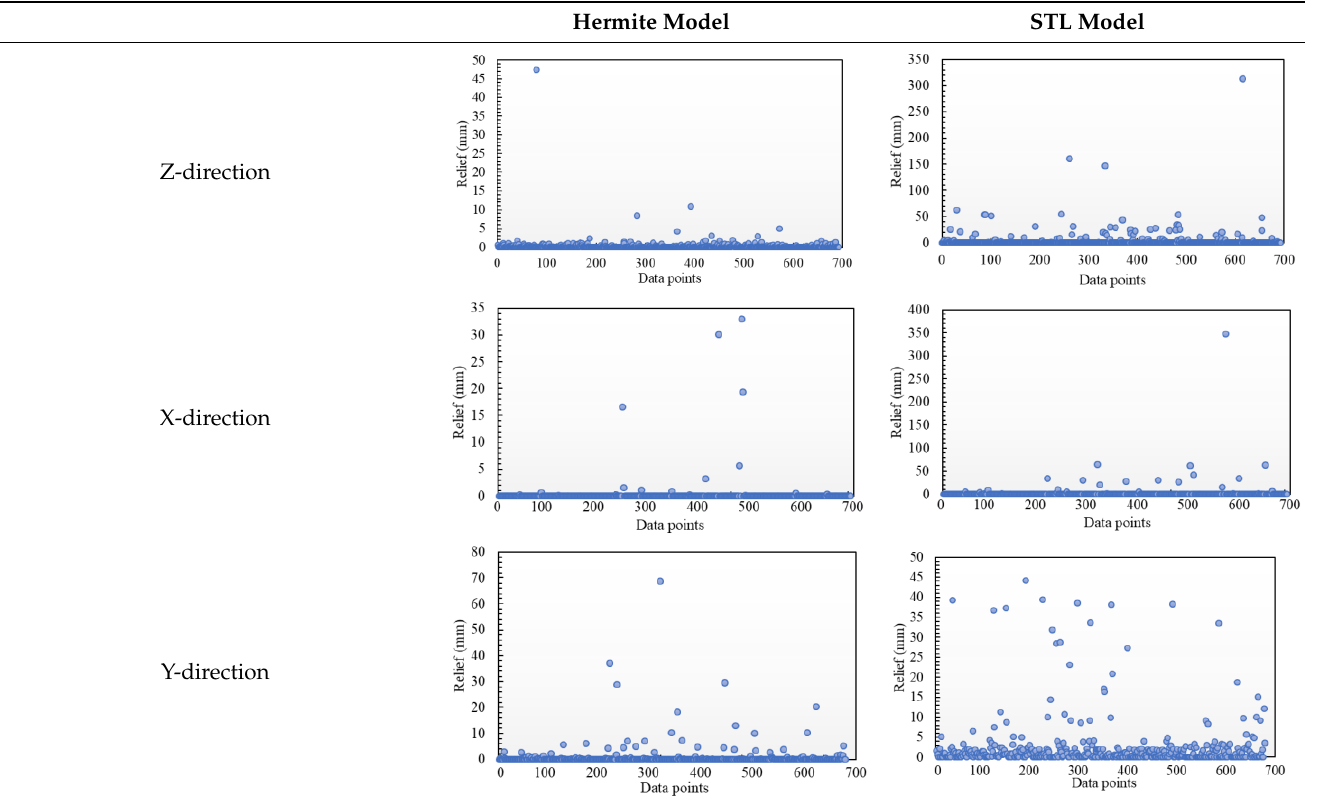
Table 3. Mean deviation in the three directions in group 5.